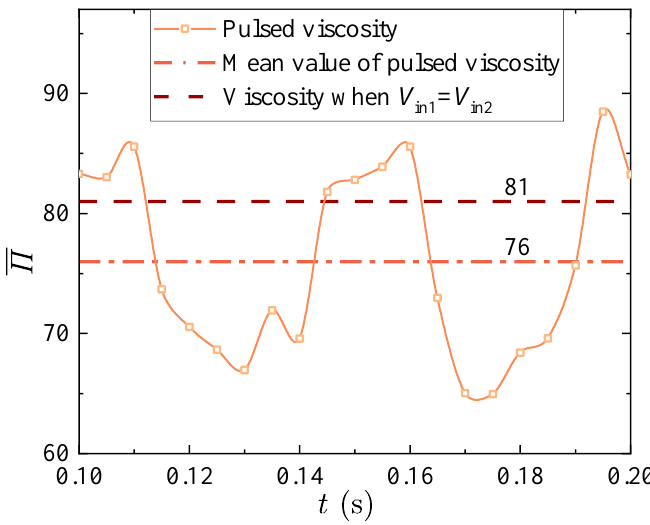
Figure 18. Mean apparent viscosity at cross section A in the Y-shape corrugated channel with pulsed and constant inlet velocity conditions.